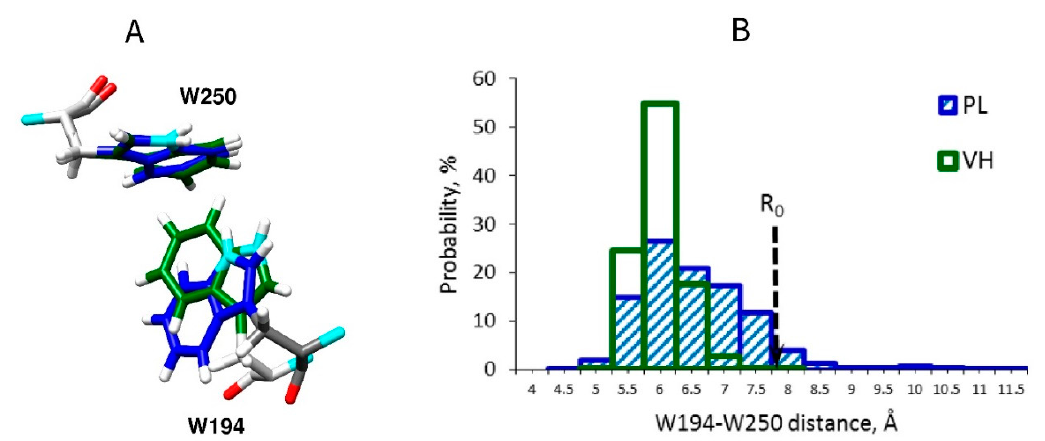
Figure 3. ( A ) Relative position of α W250 (top) and α W194 (bottom) in the structures of P. leiognathi (blue) and V. harveyi (green) luciferases. The protein structures after molecular dynamics simulations were aligned so that the positions of α W250 coincided. The corresponding FRET efficiencies between 1 La states are 86% ( P. leiognathi ) and 82% ( V. harveyi ). ( B ) The distribution of distances between α W250 and α W194 during molecular dynamics simulations of luciferases P. leiognathi (blue) and V. harveyi (green). The black arrow indicates the Förster radius (R 0 ) for FRET between the tryptophans [26].